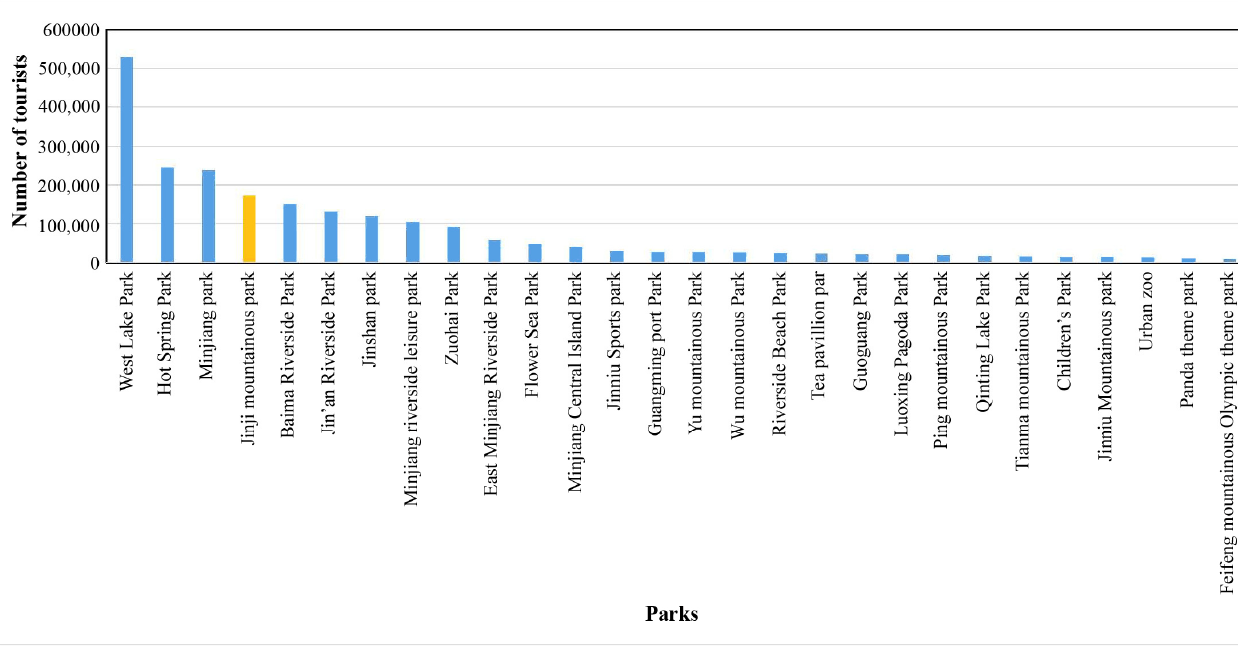
Figure 8. The statistics on the total number of visitors in each parks of Fuzhou during the investigation (Source: author remade according to reference [63]). Note: The statistics of the tourist flow volume were collected from 6:00 on 18 April to 18:00 on 24 April 2016).